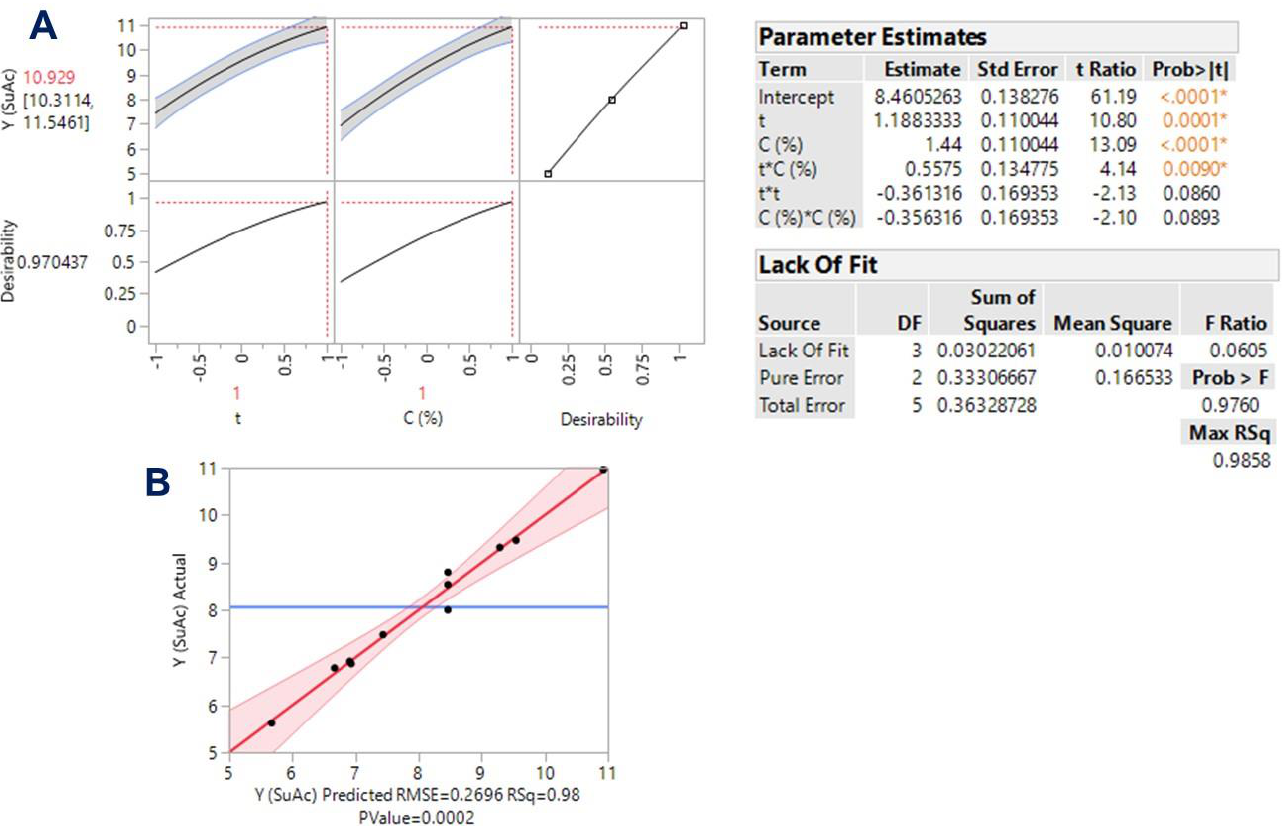
Figure 3. Plot showing the function of desirability ( A ) and the actual vs. predicted values ( B ) of the yield in total polyphenols (Y TP ), for the optimization of polyphenol release from WB using sulfuric acid (SuAc) as a catalyst. The inset tables present the statistical data related to the model built based on the response surface methodology. Values designated with different colors and asterisks are statistically significant.